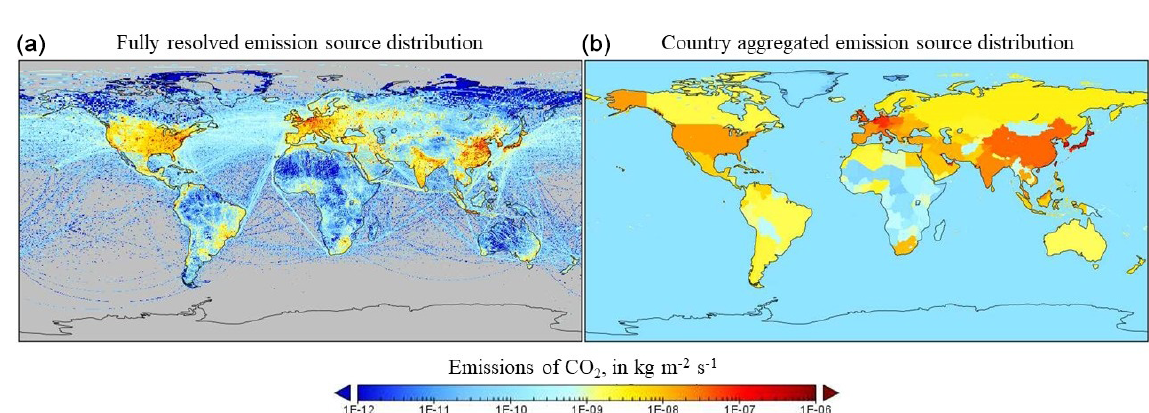
Figure 10. Anthropogenic CO 2 flux source distribution at ∼ 25km resolution – fully resolved (a) , country aggregated (b)